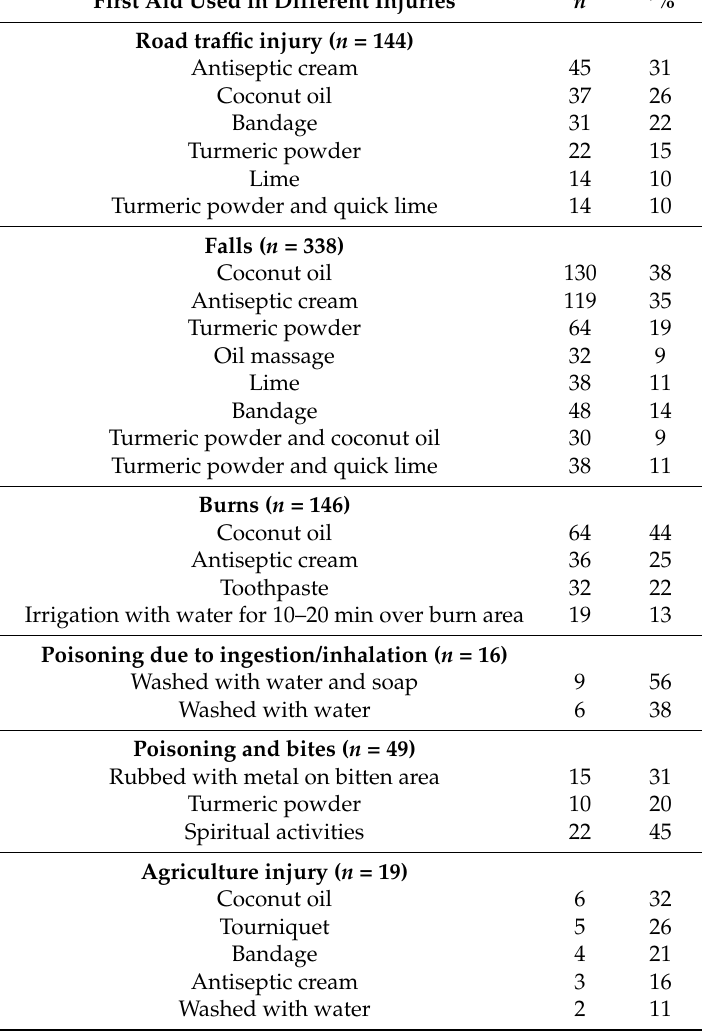
Table 5. Details of first aid provided in different